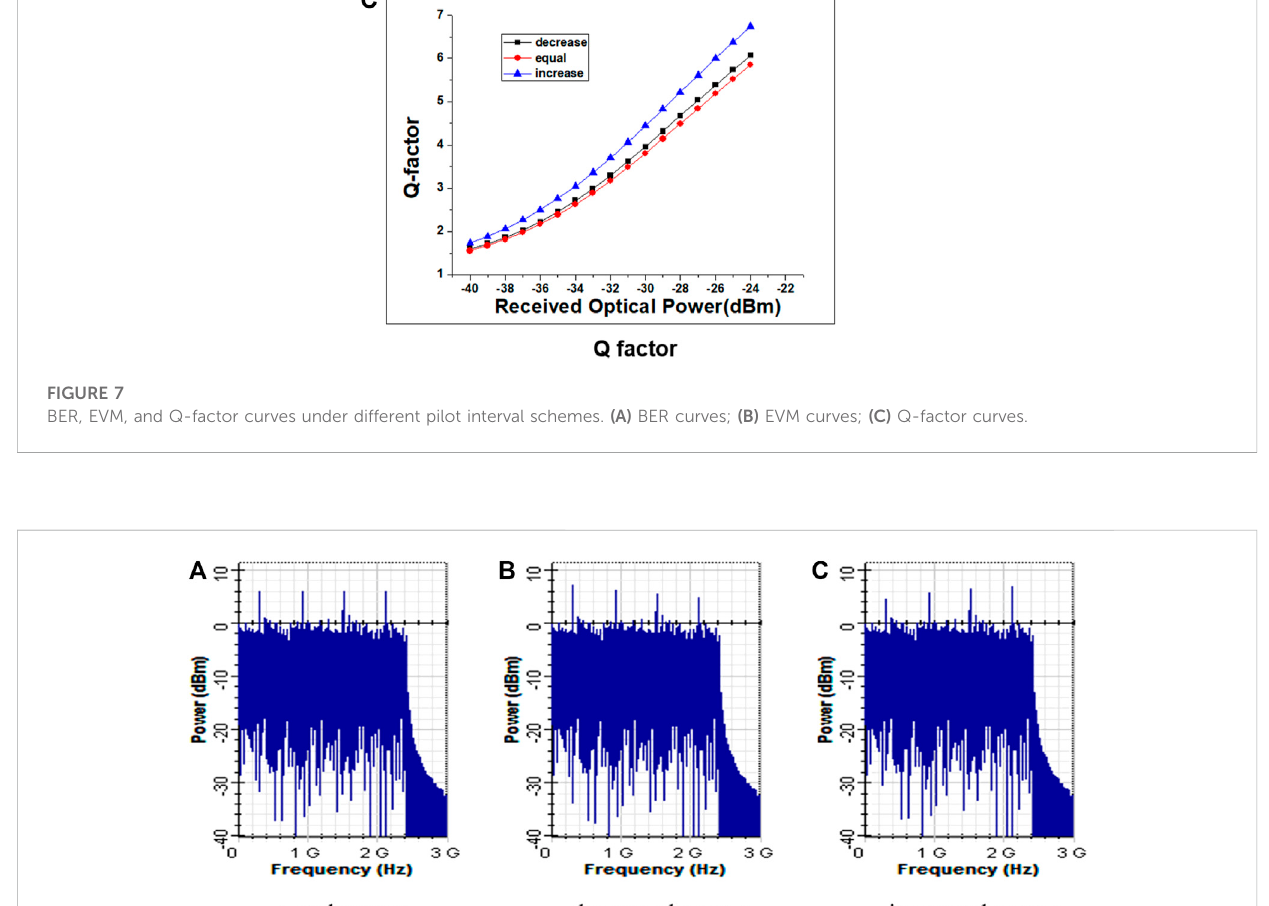
the frequency. The vertical axis represents the power. The equal- power scheme, the decreased-power scheme, and the increased- power scheme are shown in Figures 8A – C, respectively. In the three schemes, we keep the total power of the inserted pilots the same and only change the power distribution. In the pilot